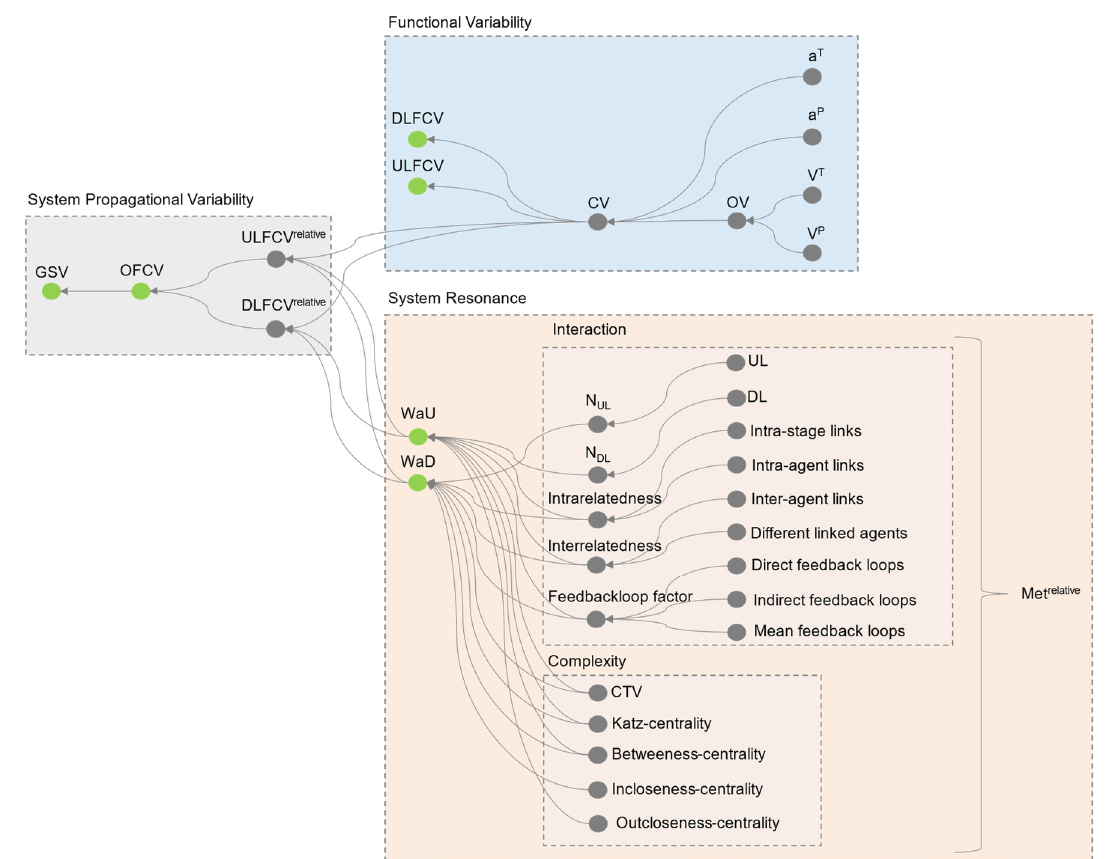
Figure 4. Structure of metrics by the semi-quantitative approach. The nodes in green represent the main analysis